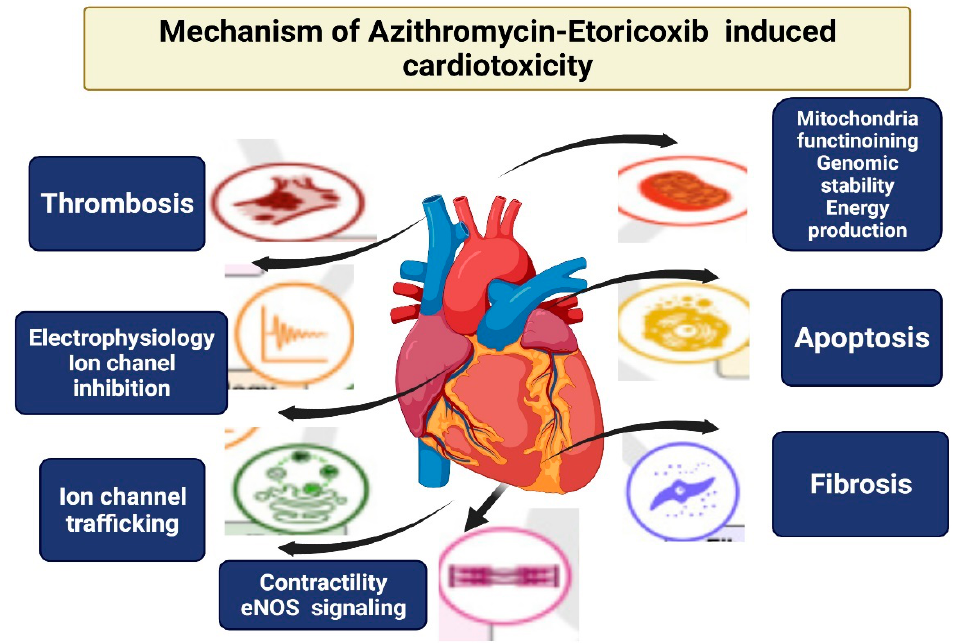
Figure 5. Mechanism of action of drug interactions causing cardiotoxicity.